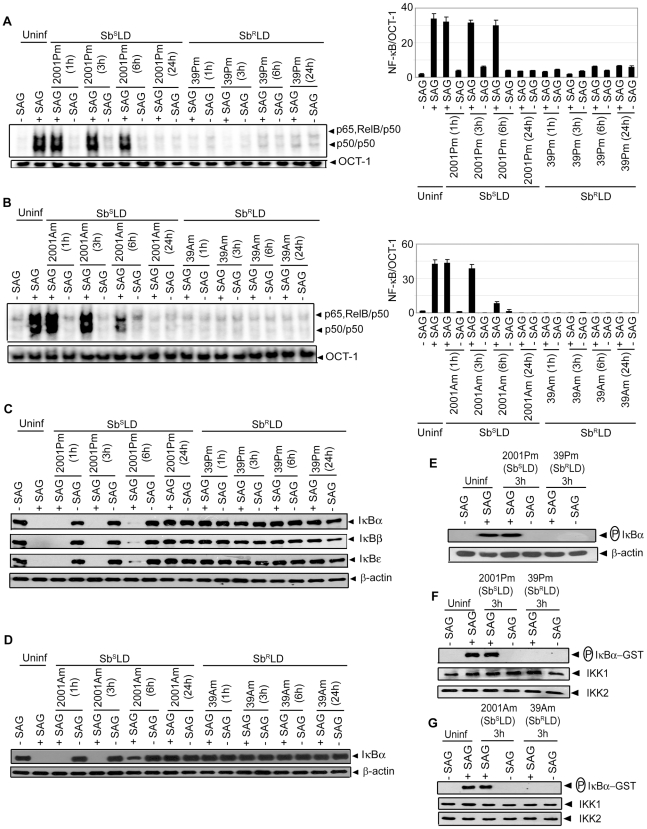
SAG-induced NF-κB signaling is inhibited in SbRLD- and not SbSLD-infected DCs.BMDCs were infected in vitro with promastigotes (Pm) (A, C, E-F) or amastigotes (Am) (B, D, G) of specified strains of SbSLD or SbRLD at a MOI 10∶1 for indicated times or left uninfected. DCs were then stimulated with SAG (20 µg/ml) for 0.3 hours. (A-B) Nuclear DNA binding of NF-κB to H2K-specific probe was measured via EMSA. DNA binding of OCT-1 was used as internal control. Densitometric analyses were determined by measuring the ratio of intensity of NF-κB to OCT-1 binding per unit area and represented as arbitrary units. (C-D) Cytoplasmic IκBα, IκBβ, IκBε and β-actin protein were detected via Western blot with same blot. (E) Phospho-IκBα was detected by Western blot. The same blot was reprobed for β-actin. (F-G) In vitro IKK activity and expression of IKK1 and IKK2 were determined as in Figure 3. Data are representative of three independent experiments. Error bars indicate mean ± SD.